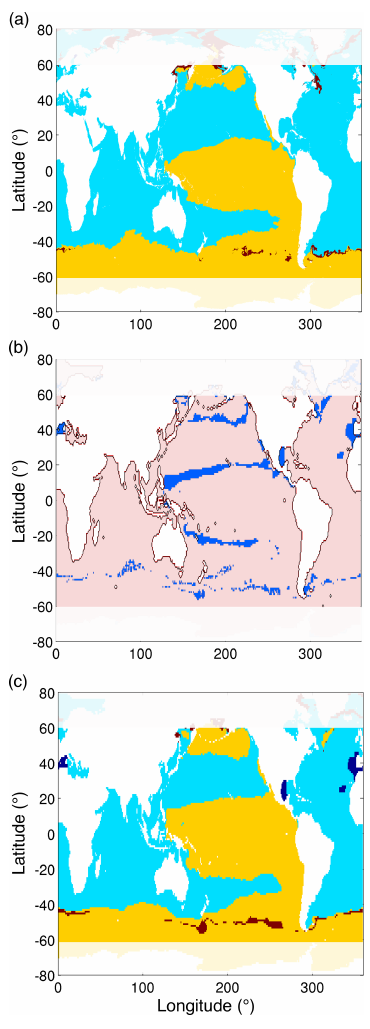
Figure 5. Limiting nutrients were assessed based on a biomass weighted average of the most limiting nutrient for each of the 78 total phytoplankton types (a) in the HR model and (c) in the CR model. Iron-limited regions are shown in orange, nitrate-limited in light blue, phosphate-limited in dark blue and silica-limited in red. (b) Regions where the model simulations predict different limiting nutrients are shown in dark blue, whereas pink regions have the same limiting nutrient in both